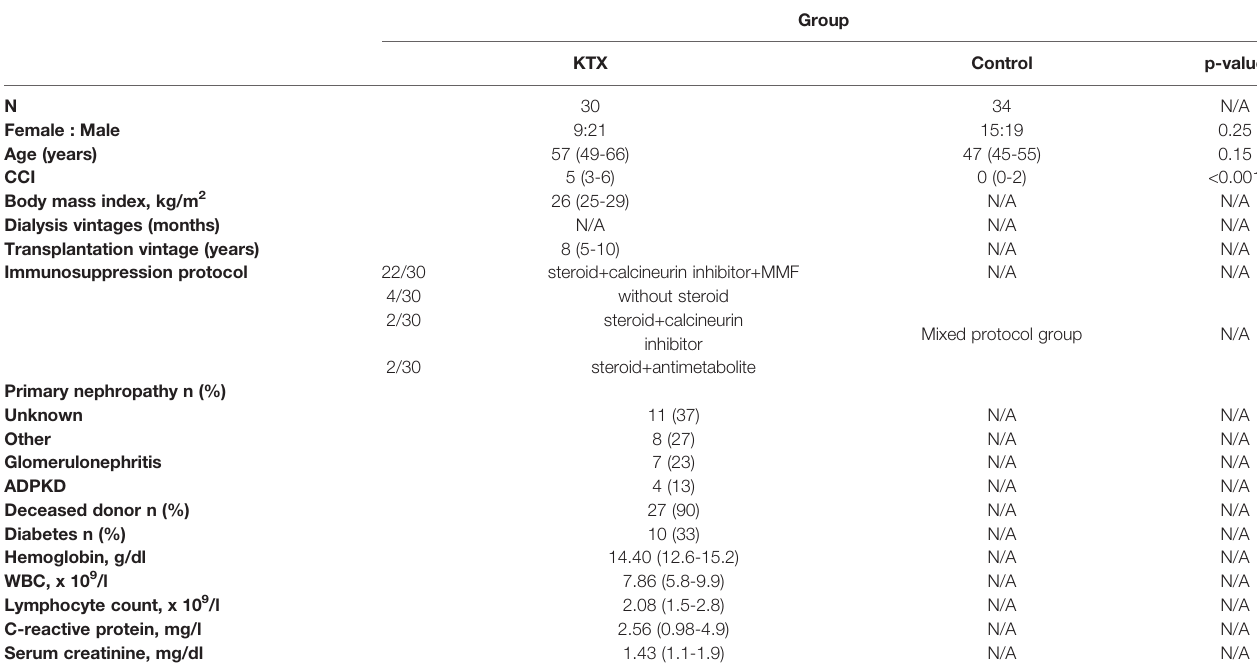
TABLE 2 | Clinical characteristics of kidney transplant recipients. Data are presented as numbers (percentage) for categorical variables or median (IQR) for continuous variables.